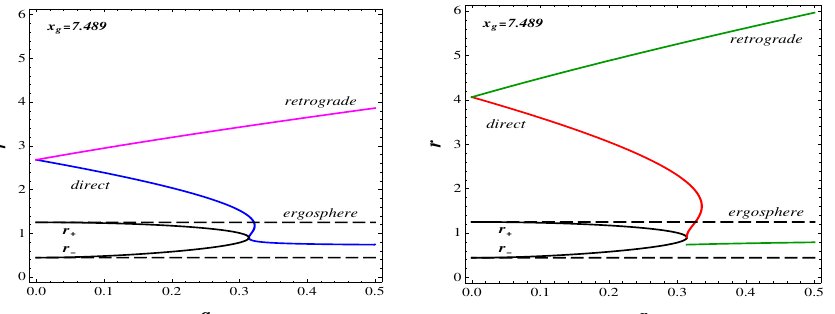
Figure 4. Dependence of radii on a for the marginally bound orbits ( left ), and for the marginally stable orbits ( right